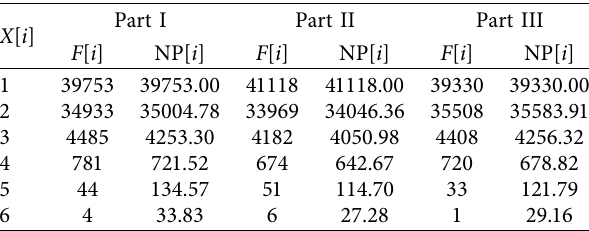
Table 6: Fitting extended logarithmic to dynamic word-length distribution data of the three parts of